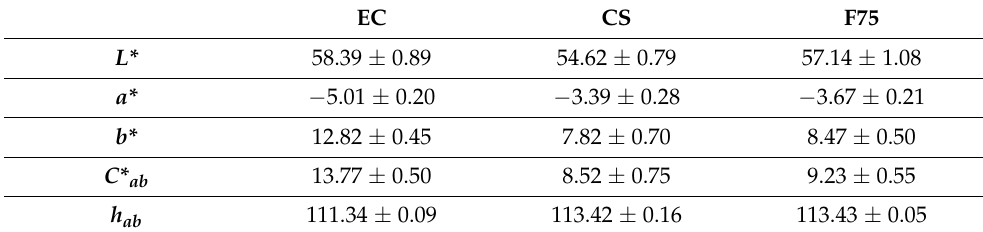
Table 4. CIEL* a* b* parameters of the hemp essential